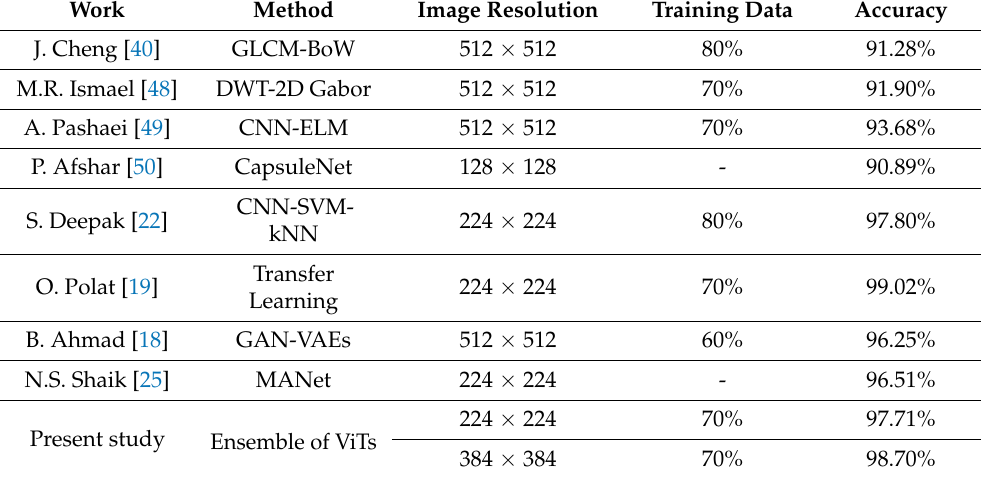
Table 5. Previous related work using figshare dataset and performance comparison in terms of overall accuracy on the test set. ViT: vision